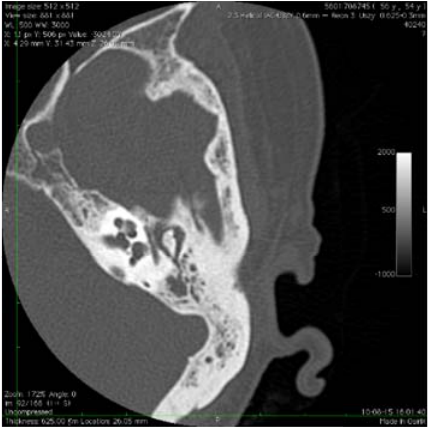
Figure 1: CT scan shows sclerotic left mastoid process and oppaci- fied tympanic cavity.